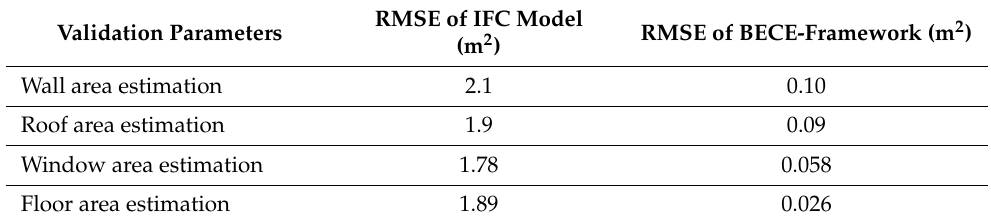
Table 6. The error of geometry information extracted from the IFC model of test case I with 18 rooms.